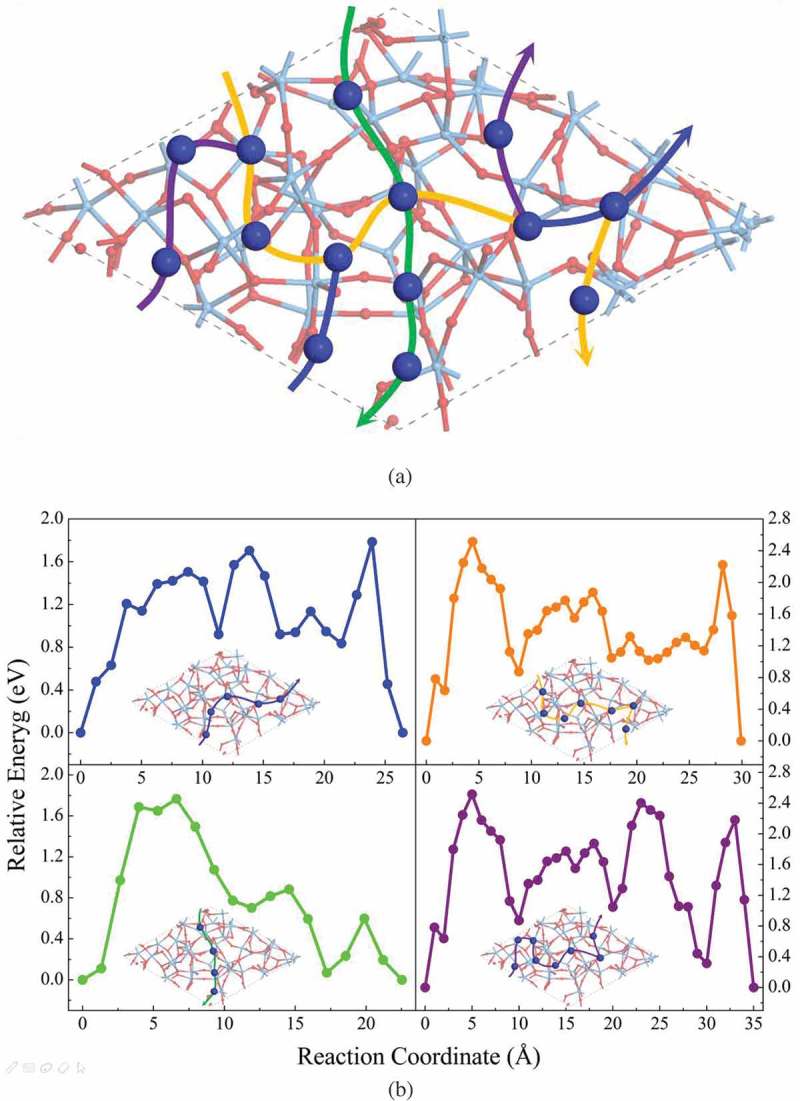
(a) The adsorption sites, the diffusion paths, and (b) the diffusion barriers of Cu on pure amorphous Ta2O5 surface.